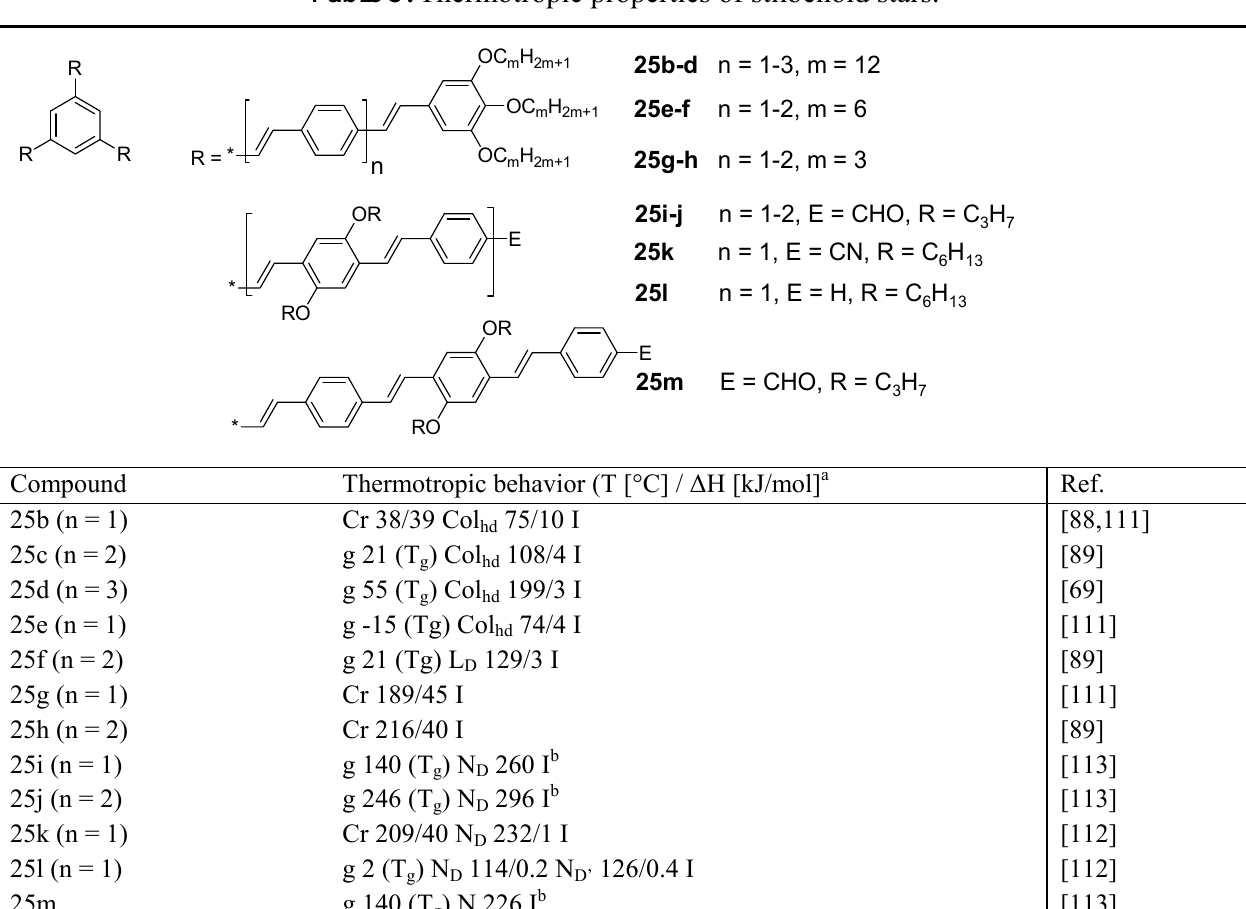
Table 3. Thermotropic properties of stilbenoid stars.